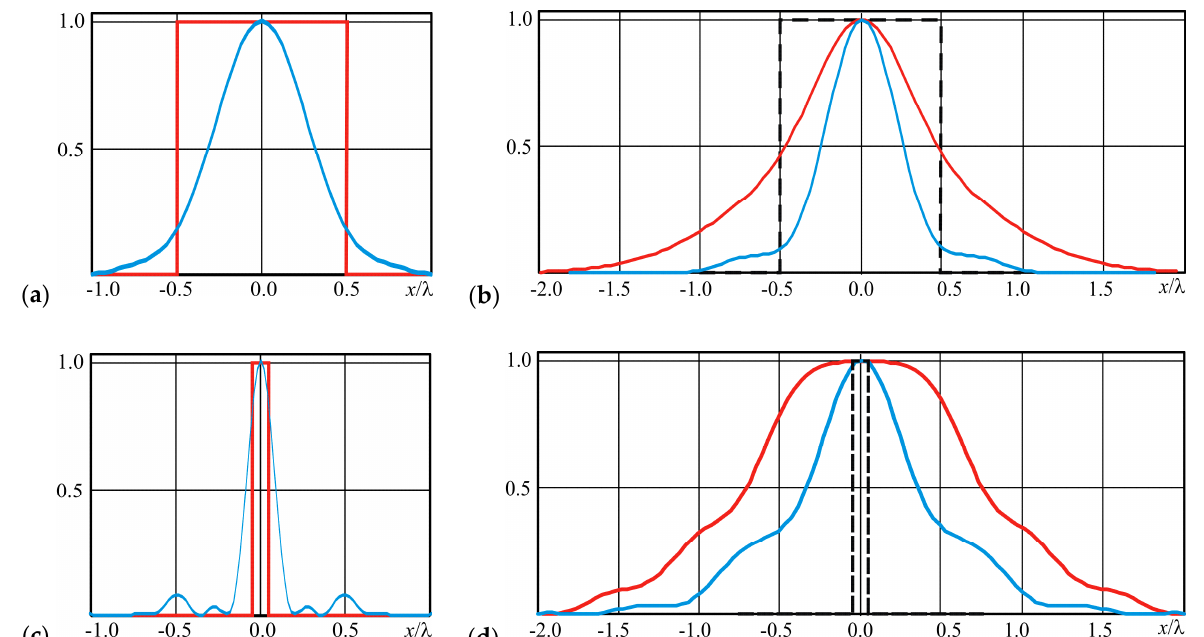
Figure 12. Generation of a compact light based on approximation of the input rectangle signal by eigenfunctions of the finite propagation operator (red color for the signal and blue color for an approximation): input signals of ( a ) 1 λ and ( c ) 0.1 λ width and corresponding diffraction results at z = λ distance ( b ) and ( d ), accordingly.